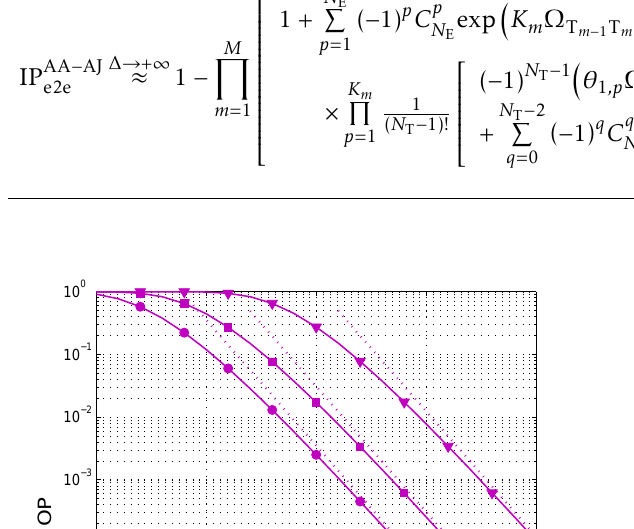
duration of each time slot decreases with the increasing of M . In Fig. 4, when M = 1, the source directly communicates with the destination, without using the relaying technique. Due to the transmission at the far distance, the OP performance with M = 1 is worse than that with M = 2. As a result, M = 2 is shown as the optimal number of hops in Fig. 4. Fig. 4 also illustrates that the OP performance significantly enhances when the number of antennas at the source and CH nodes changes from 1 to 3. It is due to the fact that the data transmission at each hop is more reliable with high number of N T . Di ff erent with OP, the IP values of all the proposed algorithms in Fig. 5 significantly decrease as increasing the number of hops ( M ). Again, we can